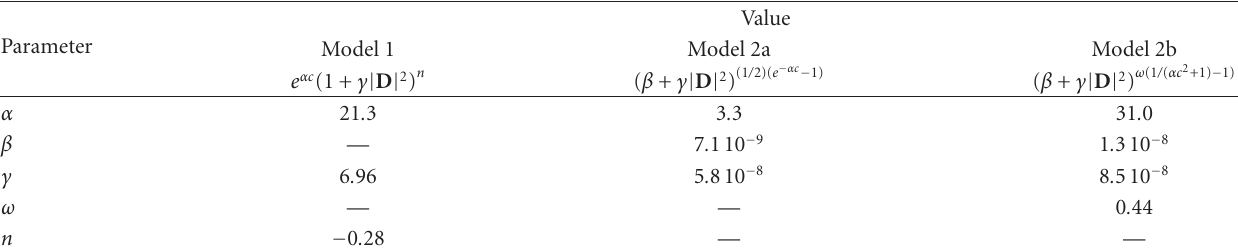
Table 1: Fitted values of the parameters for the models; μ 0 = 0 . 01 Pa · s